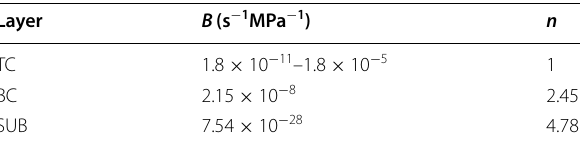
Table 3 Creep parameters of different layers in APS TBCs [42]